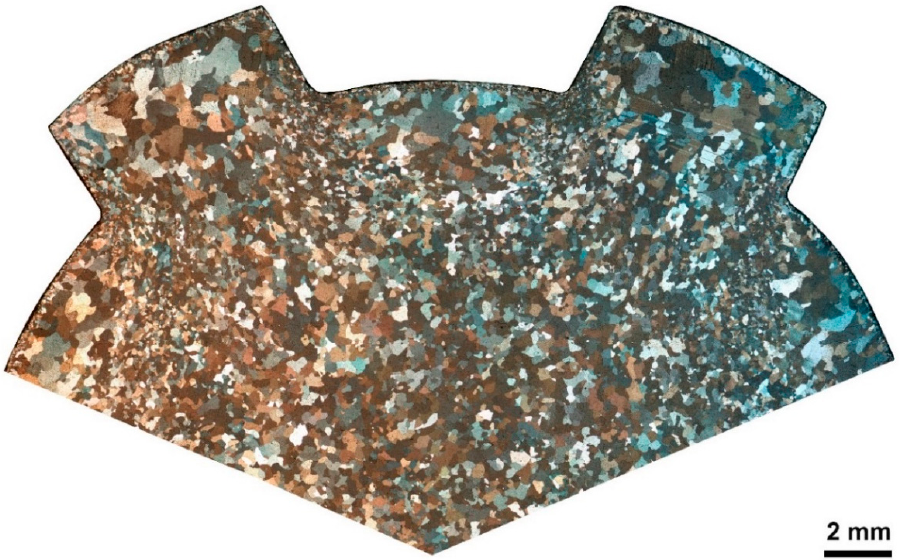
Figure 7. Macrostructure of one-third of the gear-like element (polarized LM)